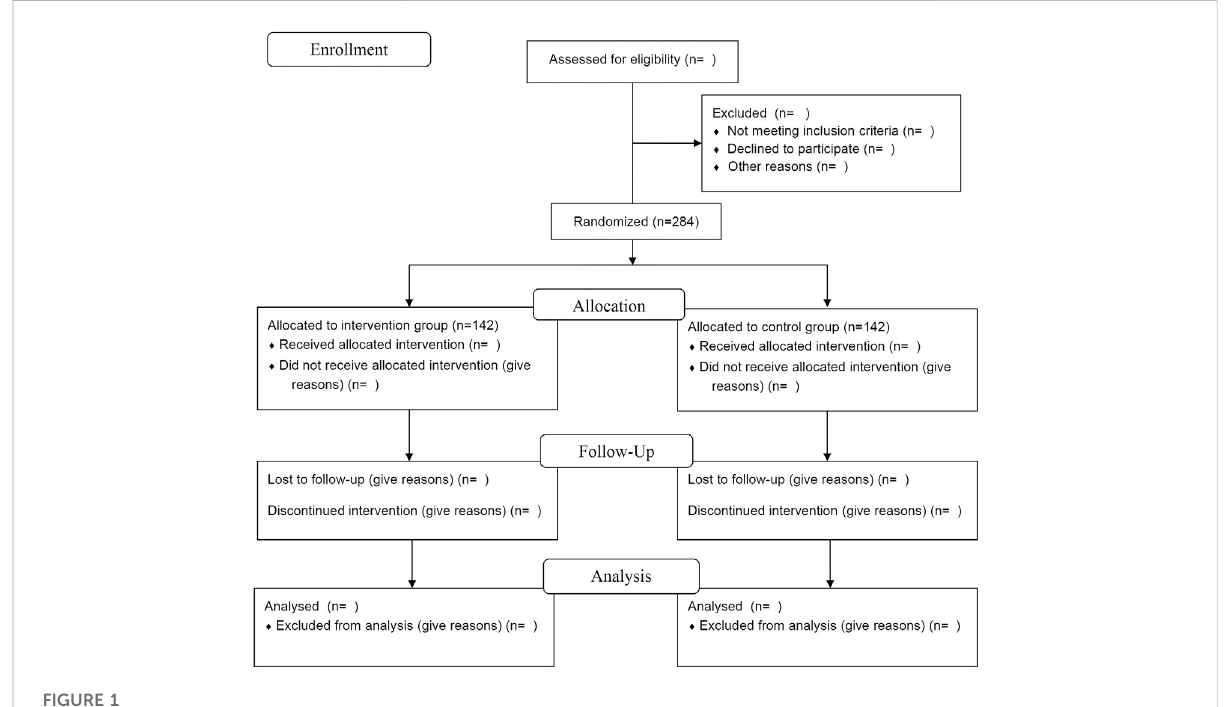
FIGURE 1 The fl ow diagram of this